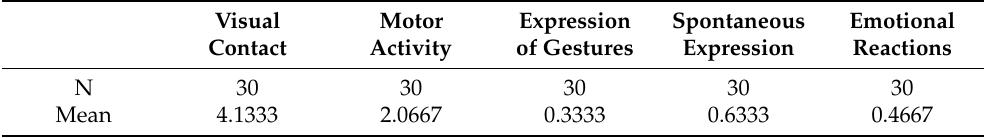
Table A4. Interest in the robot. Typical development.